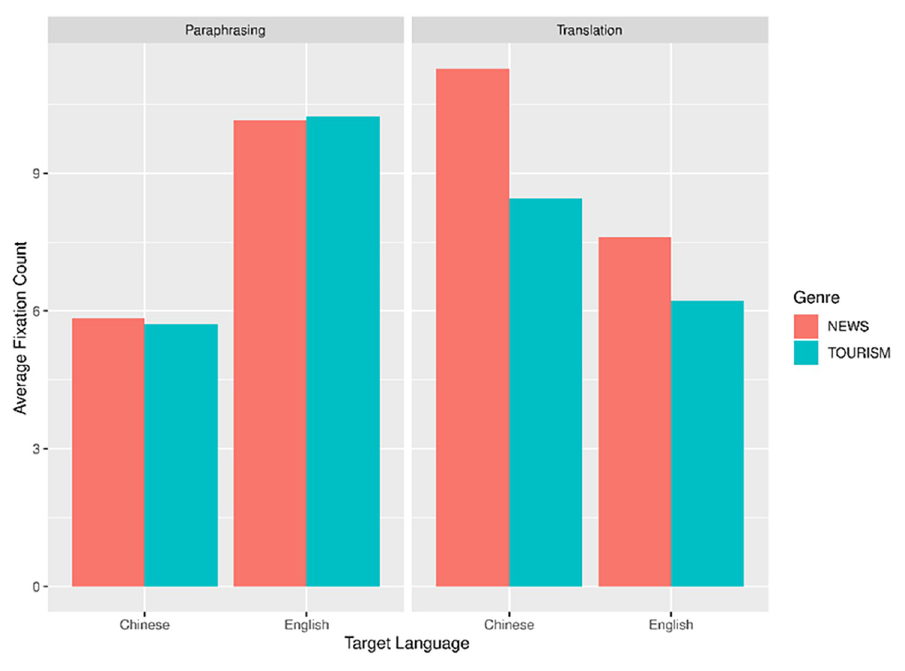
Fig 4. Average fixation count in ST.